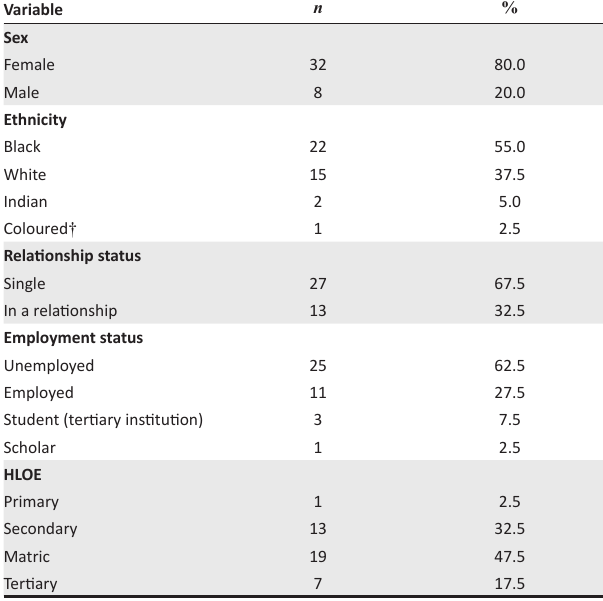
TABLE 1: Demographic profile of the overall group ( n = 40).